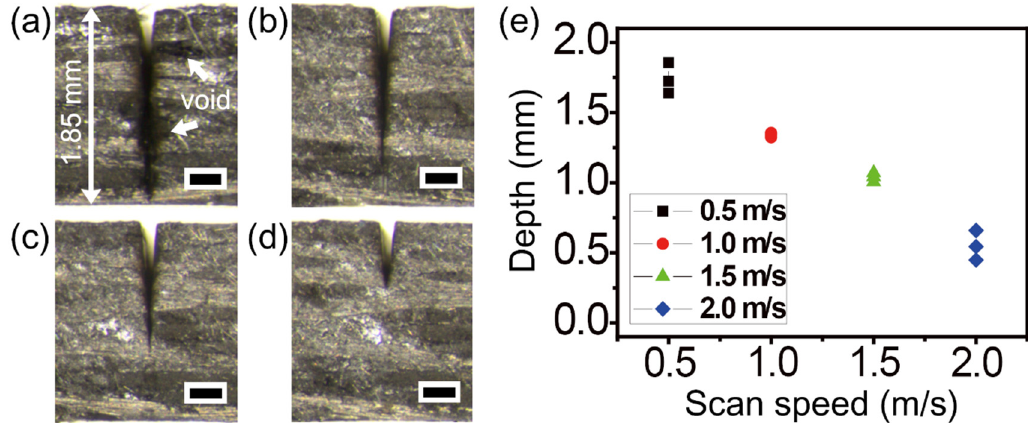
Figure 9. Picosecond laser cutting of the thermoplastic CFRP with different scan speeds. Stereoscopic microscope cross- section images with scan speed of ( a ) 0.5, ( b ) 1.0, ( c ) 1.5, and ( d ) 2.0 m/s, respectively. Each scale bar = 300 µ m. ( e ) Graph of cutting depths by scan speed variation. The common experimental conditions were a power of 22 W, 100 loops, and 10 passes with 10 µ m